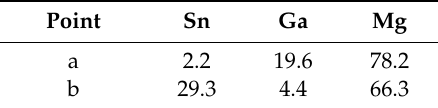
Table 3. The chemical compositions of the phases measured by WDS as indicated by the arrows in Figure 2f (in at